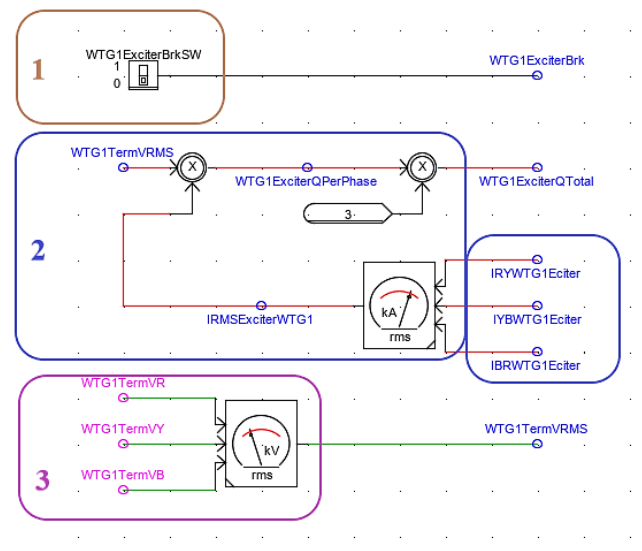
Figure 22. Excitation circuit control, monitoring, and calculation logic.